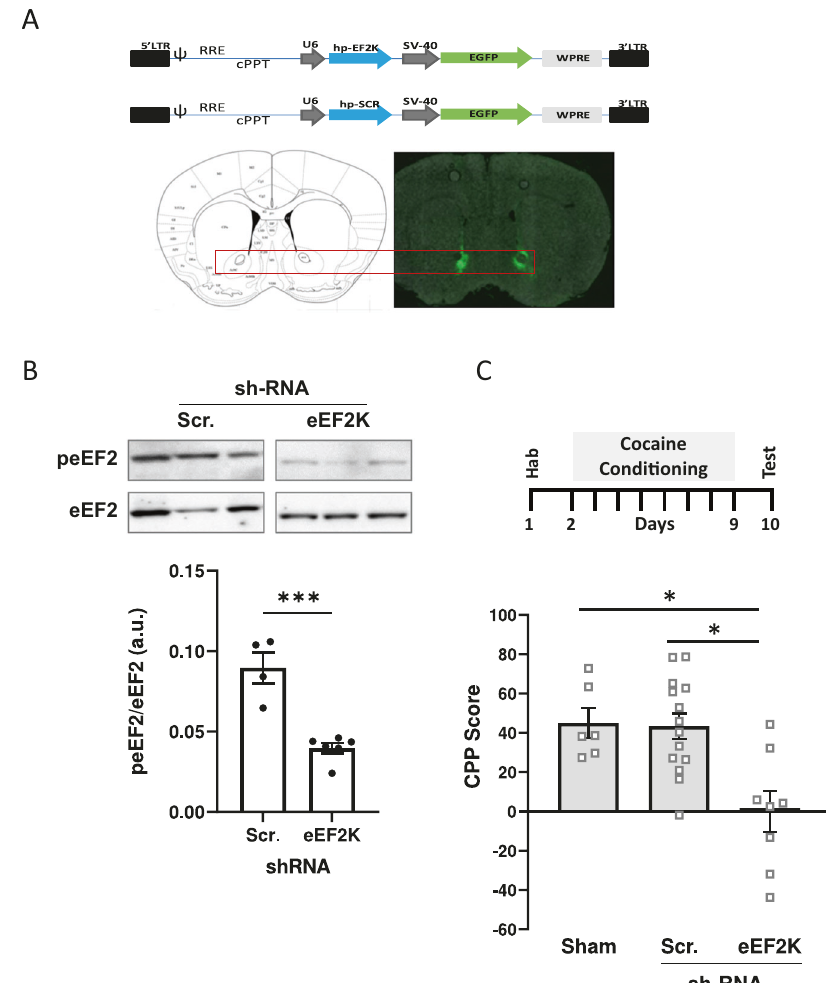
Fig. 4 Silencing of eEF2K in the NAc decreased cocaine CPP. Mice were bilaterally microinjected into the NAc with either hp-EF2K – lentiviral vector for eEF2K silencing, or with hp-SCR — lentiviral vector expressing scrambled sequence as a control. A A representative coronal section of a mouse brain slice containing the bilateral injection sites at the NAc (GFP, green), 2 weeks after the surgery. B Two weeks following injection, NAc protein samples were prepared and analysed with peEF2 and eEF2 antibodies. Histogram depicts the level of peEF2 divided by total eEF2 ± SEM (*** p = 0.0004, unpaired t -test, N = 4 – 6). C Two weeks after viral injection, all mice underwent a standard CPP paradigm. CPP test was performed for all animals 1 day after the last conditioning session. Values are expressed as mean CPP score ± S.E.M. ( n = 8 per